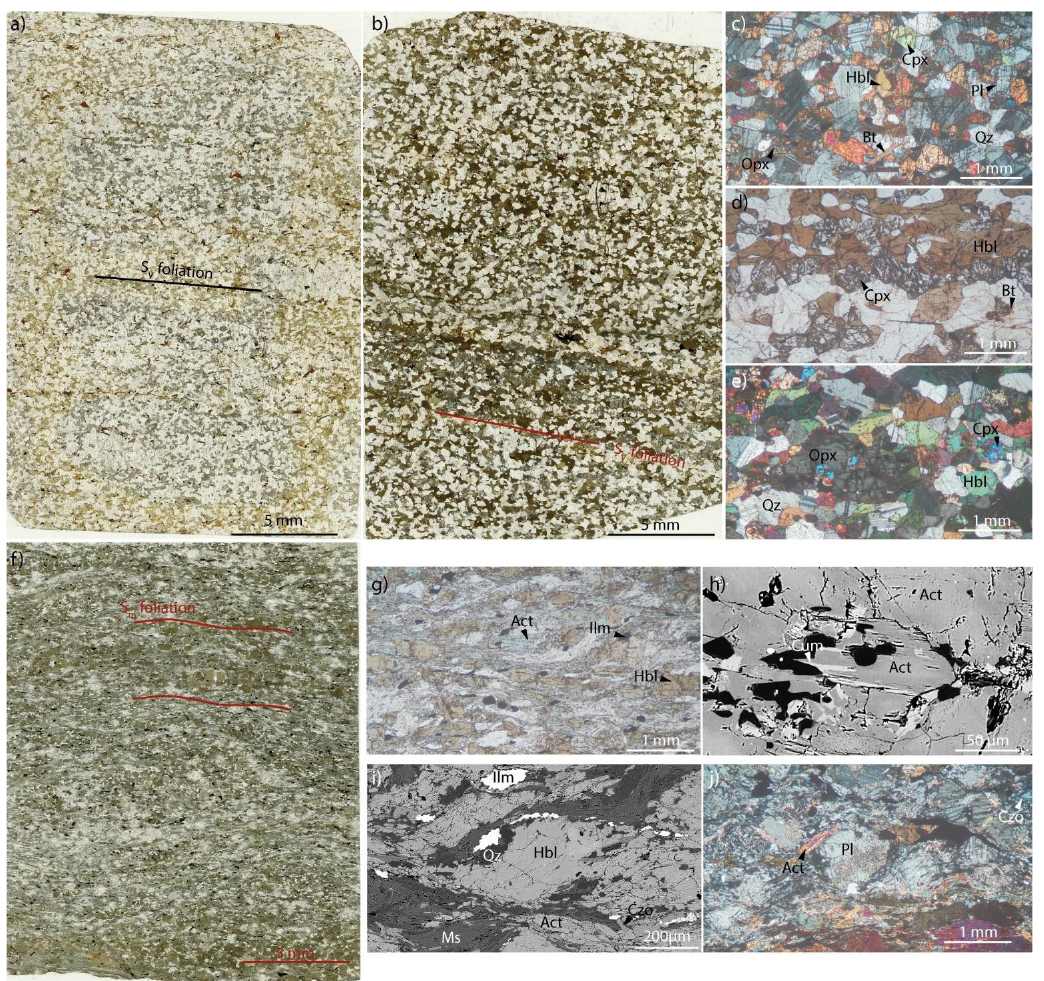
Figure 5. ( a , b ) Scanned thin sections under PPL of Cpx-Opx mafic granulite (sample FCZ36c) and Amph-bearing mafic granulite (sample FCZ36b). ( c ) Microphotograph highlighting the Variscan peak metamorphic mineral assemblage (sample FCZ36c; CPL). ( d , e ) Detail of aligned Hbl overgrowing Cpx (( d ); PPL) and Opx (( e ); CPL) (sample FCZ36b). ( f ) Scanned thin sections under PPL of mylonitic amphibolite (sample FCZ36). ( g ) Detail of pale-green Act anastomosing pre-kinematic Hbl porphyroclasts (sample FCZ36; PPL). ( h ) SEM-BSE imaging showing occasional intergrowths of Act and Cum (sample FCZ36). ( i ) Detail of a Hbl porphyroclast showing handles and lobes at the contact with Qz (sample FCZ36; SEM-BSE imaging; shear sense: top right). ( j ) Microphotograph of sericitized pre-kinematic Pl porphyroclast enveloped by a fine-grained recrystallised quartz-feldspathic matrix (sample FCZ36; CPL).